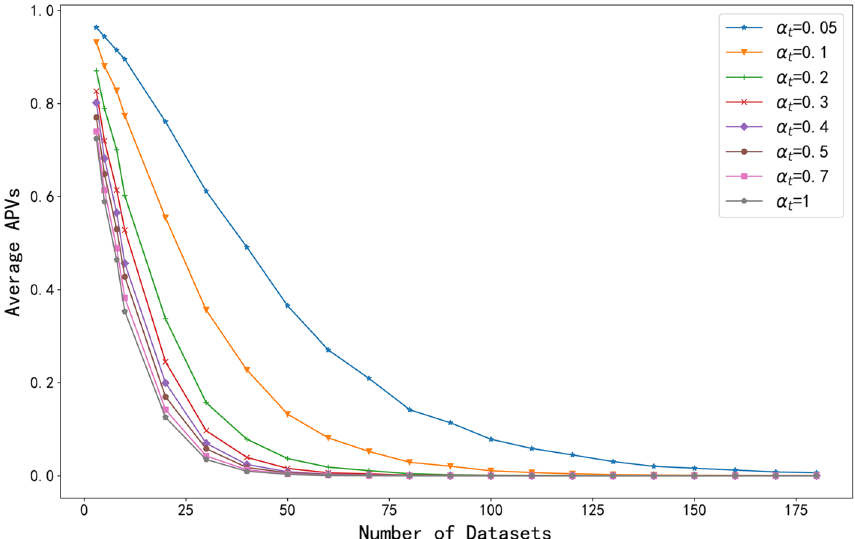
abscissa is the number of datasets N , and the ordinate is the average APVs of 1000 Monte-Carlo replications. With the same numbers of algorithms K and datasets N, the average